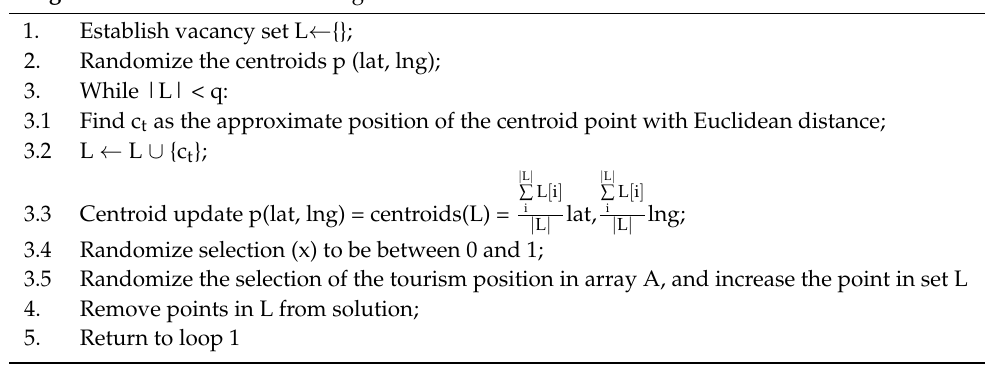
Algorithm 4. Relative removal algorithm.